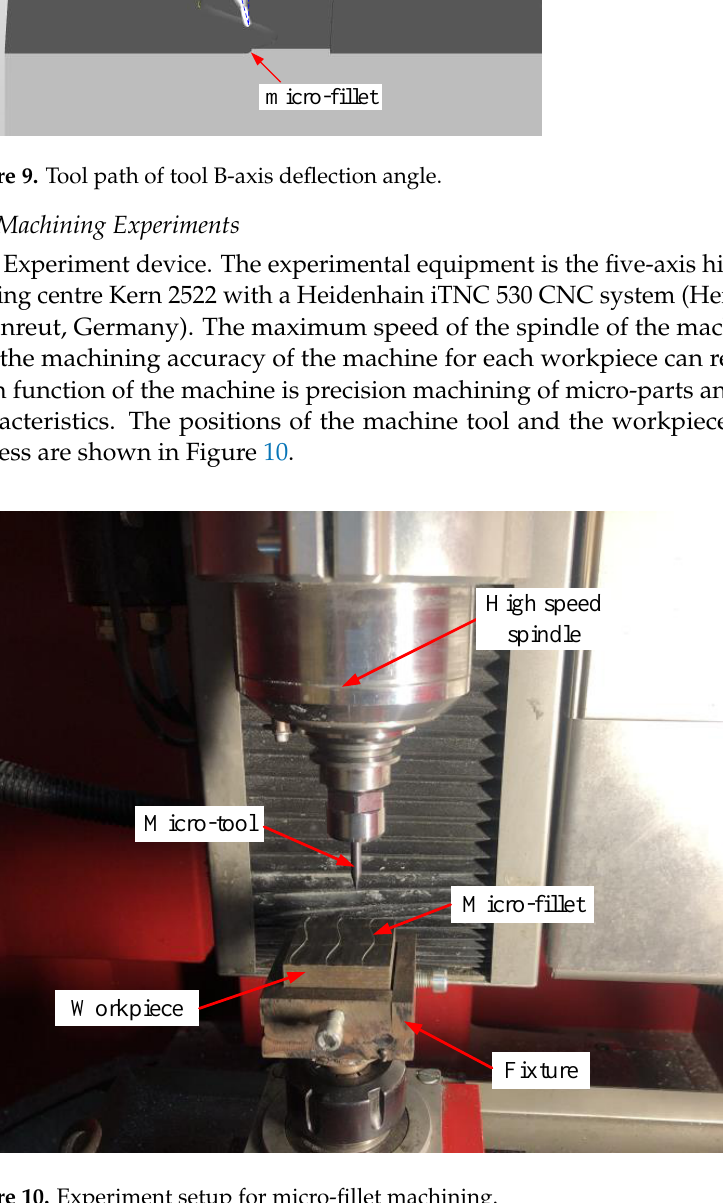
Figure 10. Experiment setup for micro-fillet machining.